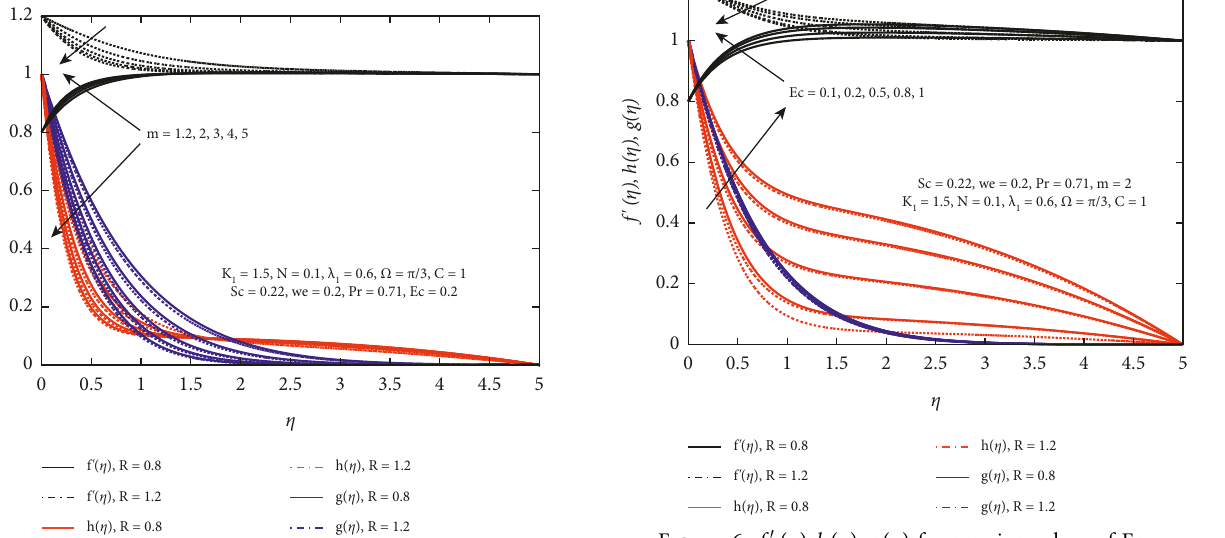
,h ,g η η η for growing values of ( ) ( ) ( ) ′